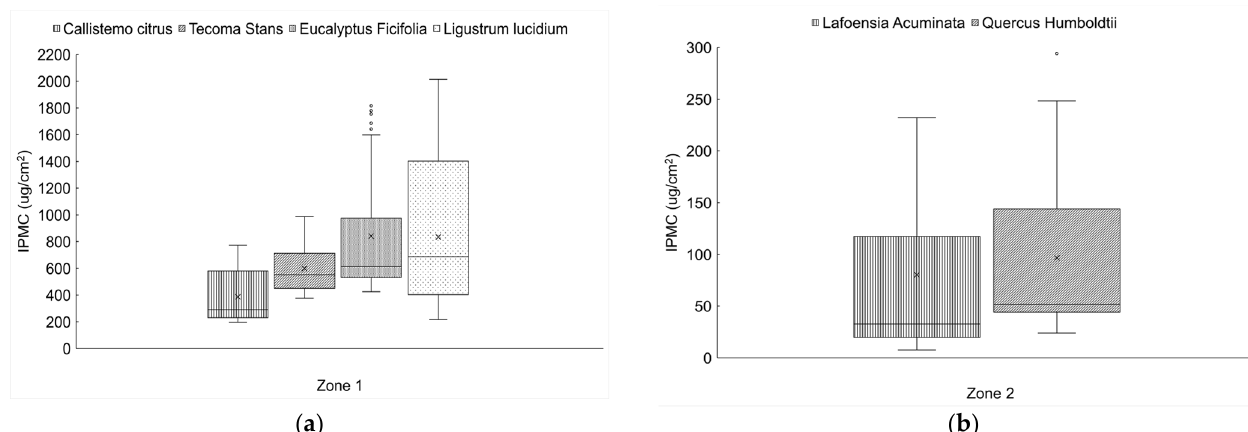
Figure 2. Diagram of boxes and whiskers for daily IPMCs of the species under study.